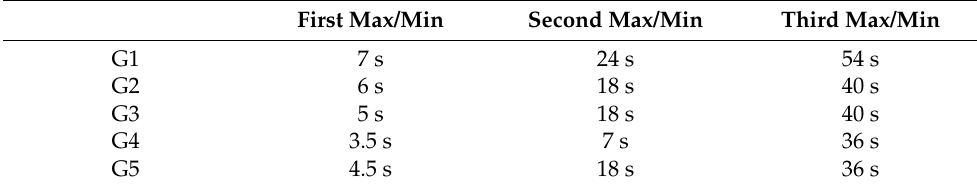
Table 4. Time to reach maximum/minimum tilting of the web for all geometry types. First